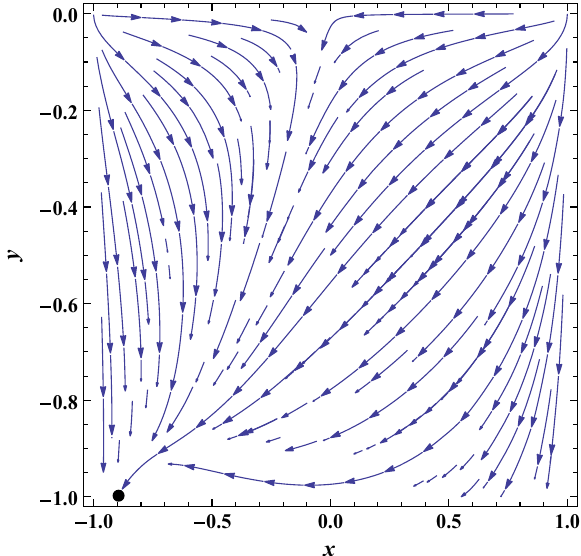
Fig. 6 The figure shows the phase space trajectories for the coupled tachyon field. The stable fixed point is an attractive node and corre- sponds to β = 0 . 9 and λ = 1. The black dot represents the stable attractor